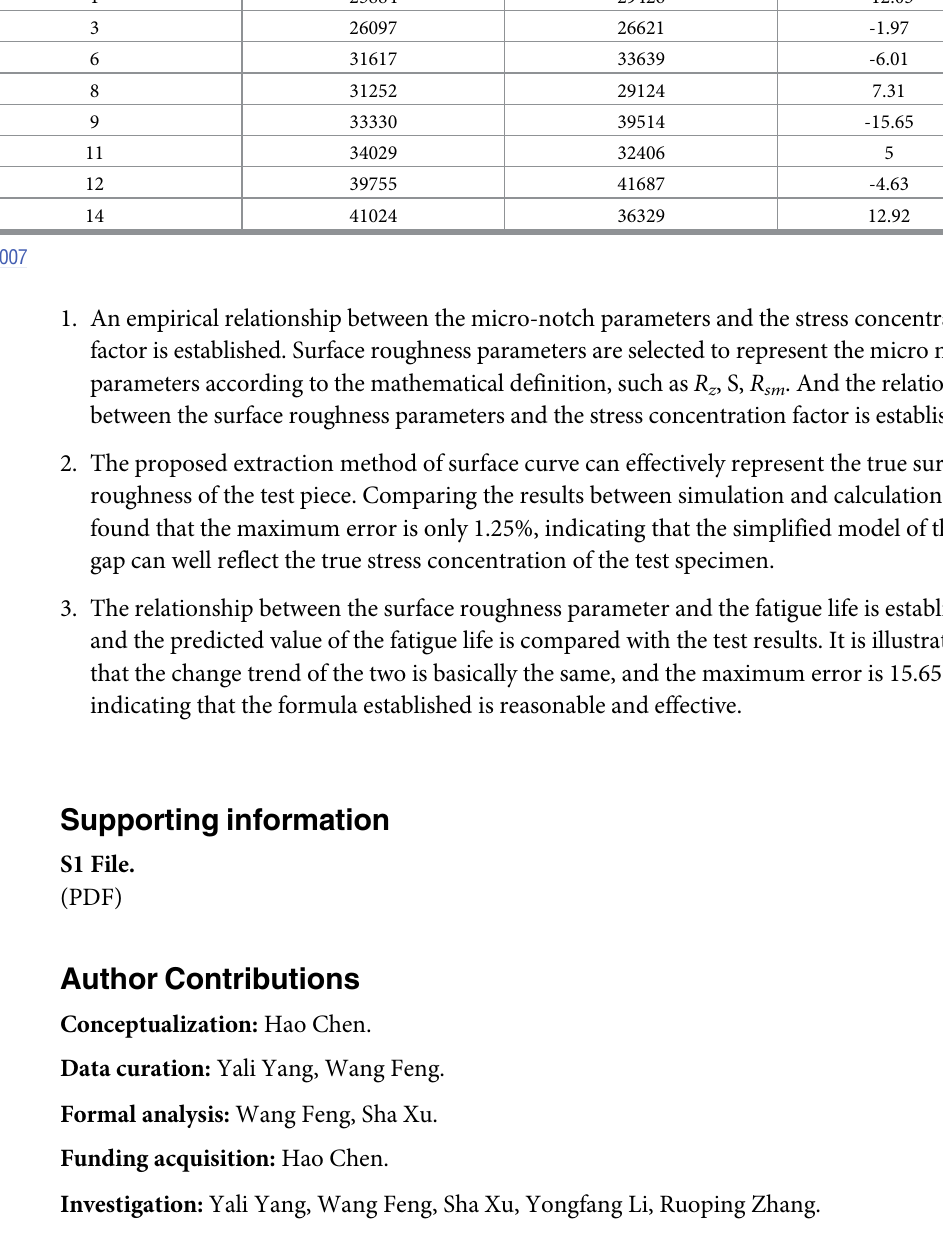
Table 7. Comparison of fatigue life for prediction and experiment. Specimen